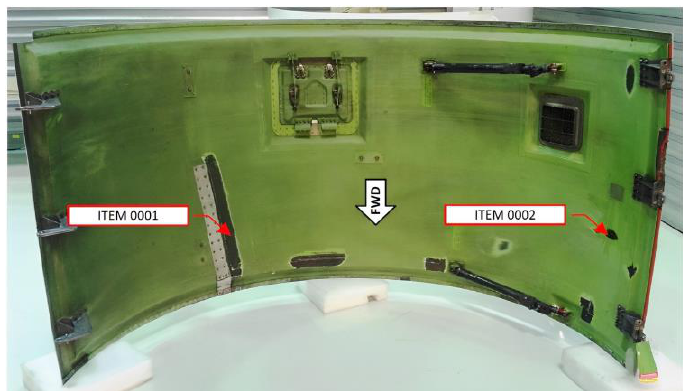
Figure 5. A320 fan cowl doors and support struts.